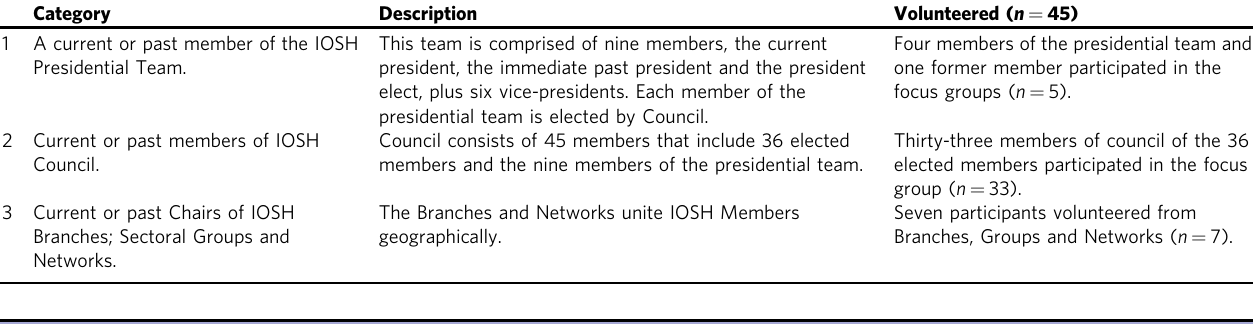
Table 4 Participant occupational classi fi